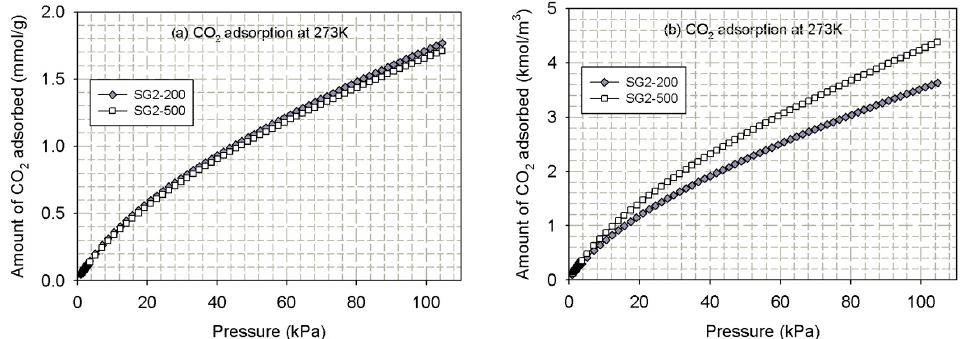
Figure 8. CO 2 isotherms at 273 K for porous silica glass prepared at pH 2, ( a ) adsorbed amount plotted in mmol/g and ( b ) adsorbed amount plotted in kmol/m 3 .